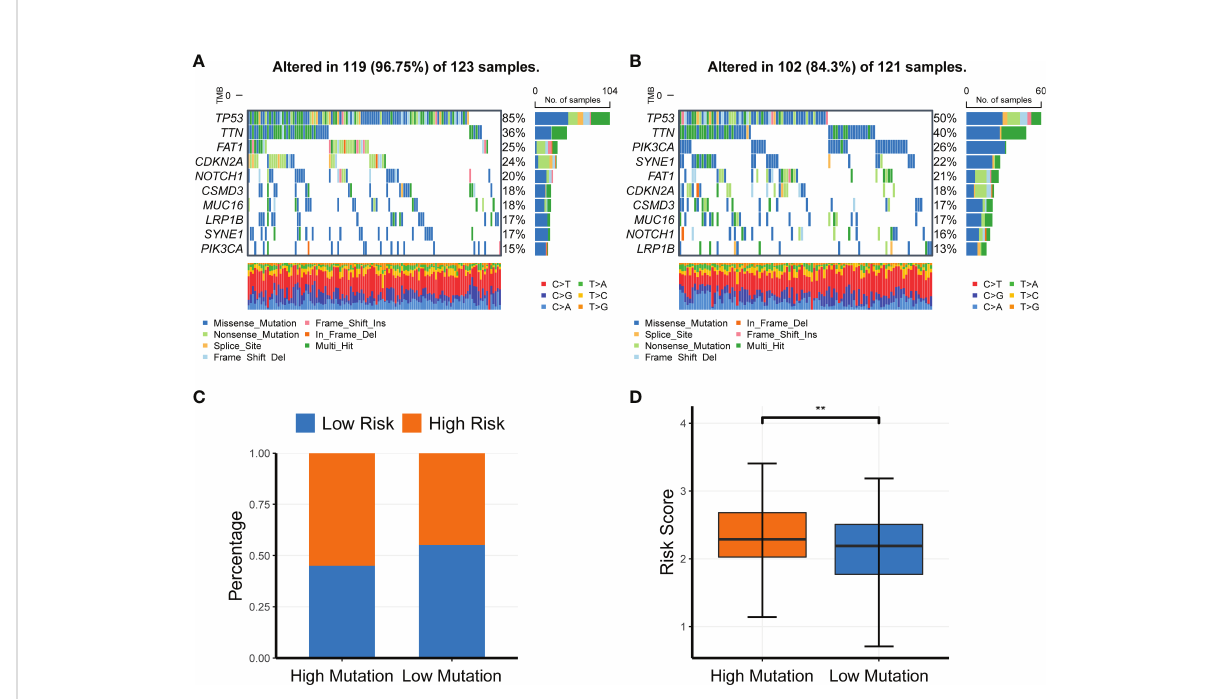
FIGURE 7 Pro fi ling of somatic nucleotide variation for head and neck squamous cell carcinoma patients of different risk groups. (A, B) Waterfall plot of the nucleotide variation rate in the high-risk group and the low-risk group. (C, D) Bar plots and box plots of risk scores in the high-mutation group and low-mutation group. ** P <